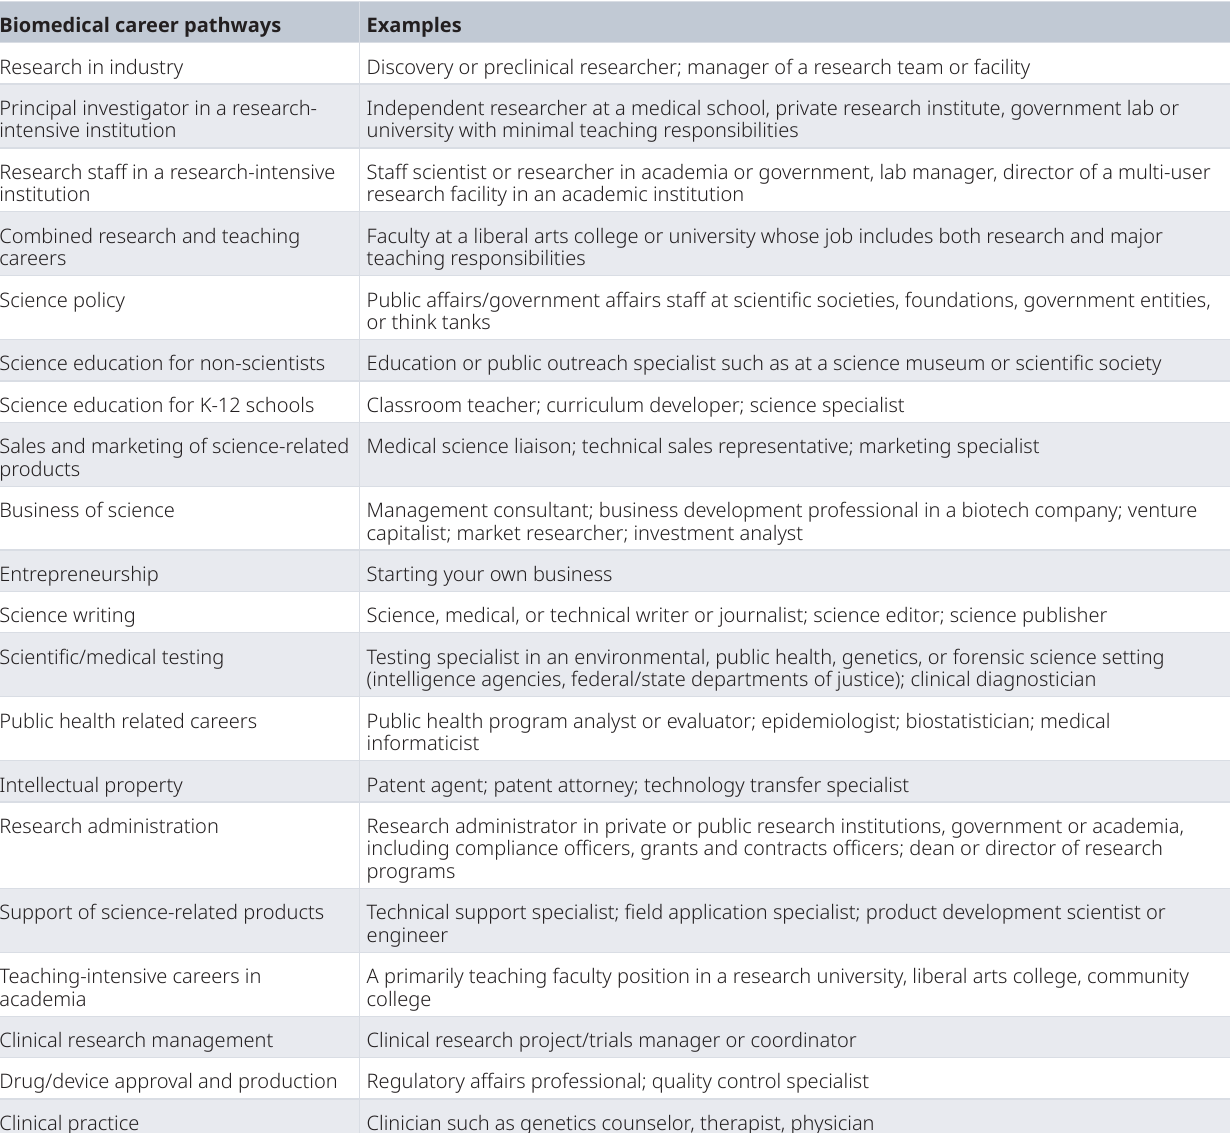
Table 2. MyIDP biomedical career pathways. Sample biomedical career pathway definitions drawn from MyIDP are displayed to illustrate the diverse career options available to graduate and postdoctoral trainees during career